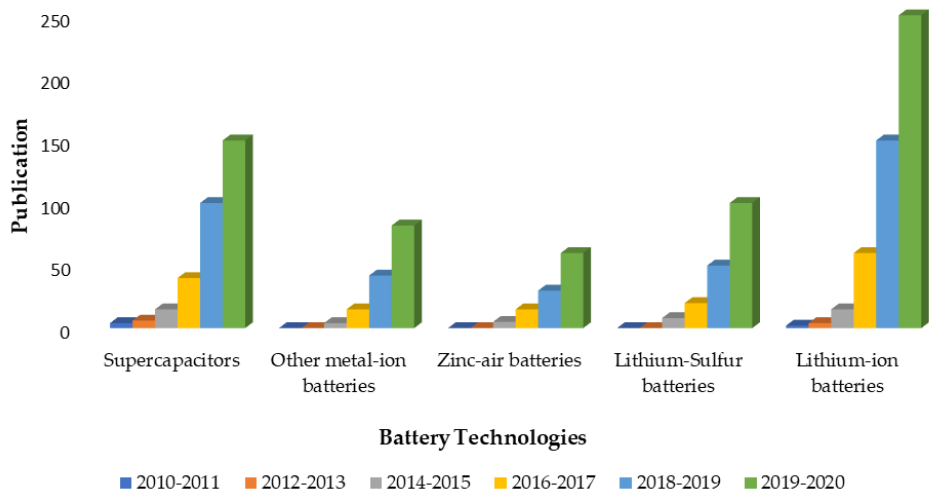
Figure 9. No. of publications on different battery technologies.